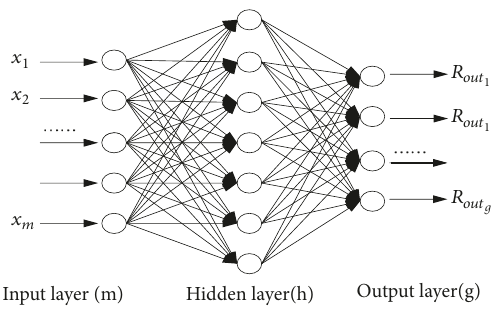
Figure 2: The topology structure of BP neural